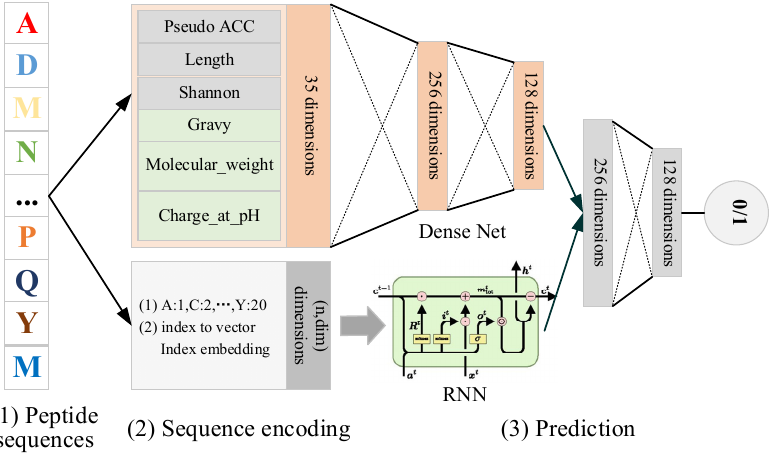
Figure 2. The overall workflow of ACPNet.